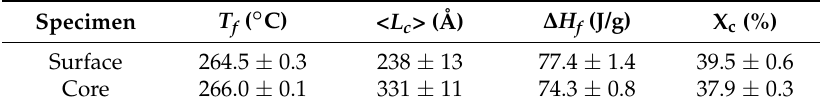
Figure 11. ( a ) Differential scanning calorimetry (DSC) traces of surface and core samples (endotherms are positive values); ( b ) lamellae thickness distribution deduced of (a) and Equation (1) in the core (red) and in the skin (blue). Table 1. Melting temperature, T f , average lamellae thickness, < L c >, melting enthalpy, ∆ H f and apparent crystallinity ratio in mass, X c , regarding surface and core samples.